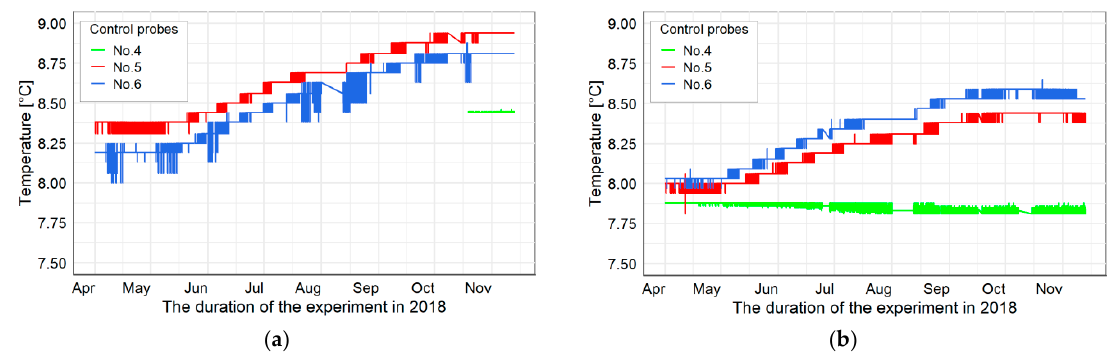
Figure 3. ( a ) The disturbed ground temperature profile for control probes No. 4, No. 5 and No. 6 at a depth of 40 m. ( b ) The disturbed ground temperature profile for control probes No. 4, No. 5 and No. 6 at a depth of 70